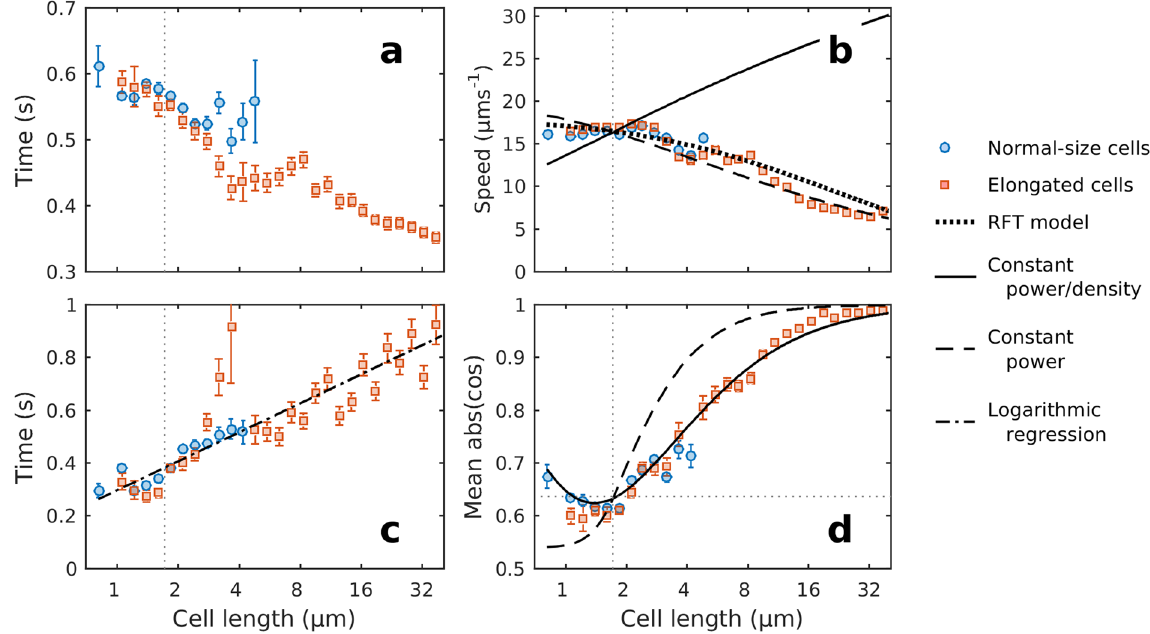
Figure 2. Swimming parameters vs . cell length. Run times ( a ), mean run speeds ( b ), tumble times ( c ), and absolute values of the cosines of tumble angles ( d ) for all tracks in each treatment were binned into logarithmically distributed size classes, and then mean values were obtained for each class. Blue circles represent control cells, and red squares represent cephalexin treated cells. Error bars represent the standard error of the means in each size class. Vertical grey dotted lines in all plots mark the average length of untreated E. coli . Horizontal grey dotted line in d marks the value corresponding to a uniform distribution of angles. Black lines in b and d represent the power density models (solid line, equations (6) and (8) respectively), the constant power models (dashed line, equations (7) and (9)) and the RFT model (dotted line, equation (3)). Dash-dot line in c is the best least-squares regression model between the logarithm of the tumble angle and the tumble time, after forcing the model to cross the value for normal-size cell: t = t n + b log 10 ( l / l n ), where t is tumble time, l the length of the cell, and subscript n refers to normal-size cells estimates [ b ± s.e. = 0.37 ± 0.02; R 2 = 0.82; d.f. = 27]. Note the base-2 logarithmic axes for cell